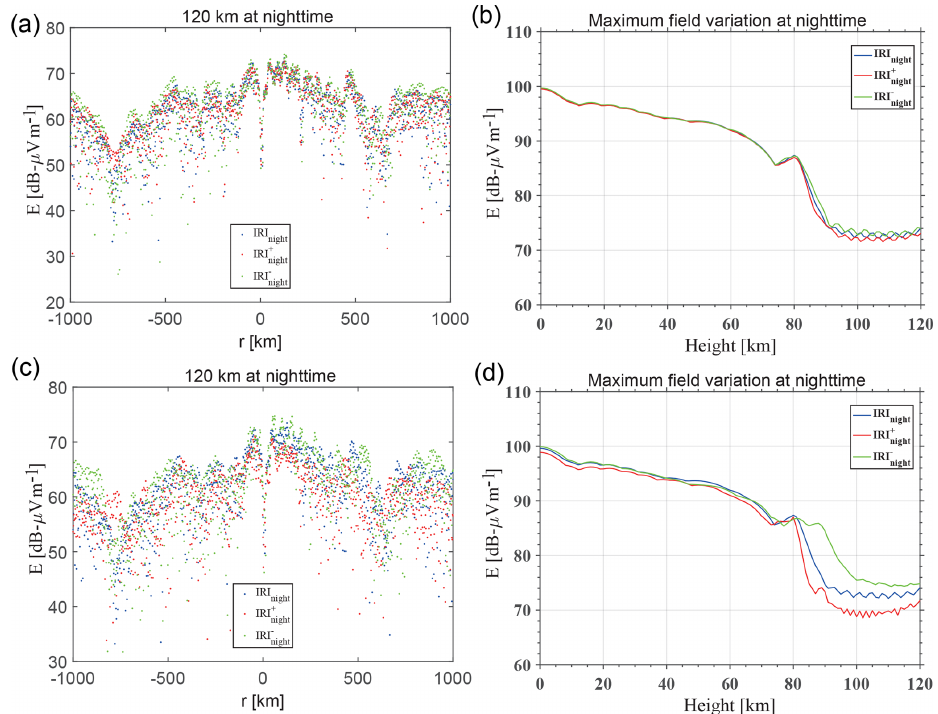
Figure 10. The total electric field excited by the ground-based VLF transmitter NOV with a transmitting frequency of f = 11 . 9kHz and power of P = 500kW. The total electric field at the altitude of 120km (a) and the maximum electric field varying with altitude (b) at nighttime when the Gaussian shape disturbance is set to 1.3 times compared with original electron density. The total electric field at the altitude of 120km (c) and the maximum electric field varying with altitude (d) at nighttime when the Gaussian shape disturbance is set to 4 times compared with original electron